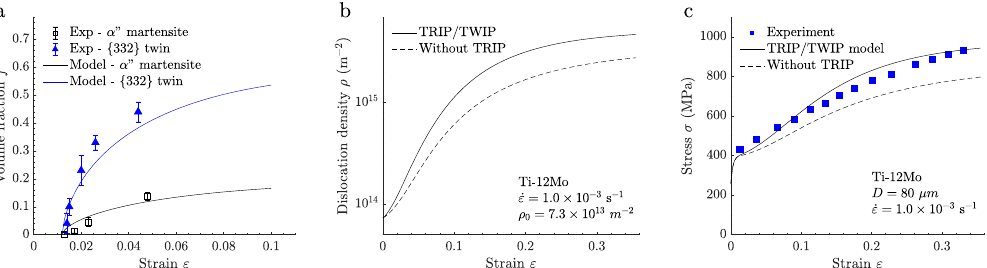
Fig. 2 Microstructural evolution and mechanical response of Ti-12Mo. a The growth of {332} 〈 113 〉 twin and α ″ martensite volume fraction ( f tw and f α ″ , respectively) at the onset of critical strain. The error bars on twin fraction were adopted from the experimental measurement 13 . b The evolution of total dislocation density. c The experimental and modelled fl ow stress. The dash curve predictively illustrates the fl ow stress without TRIP contribution.